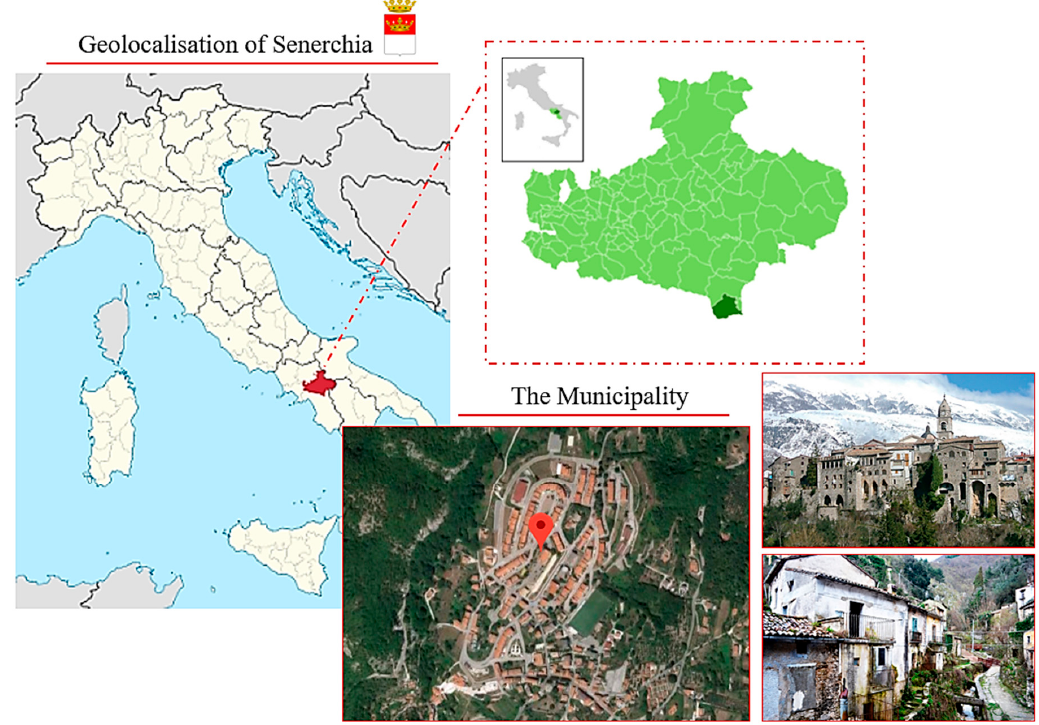
Figure 1. The geographical localisation of the municipality of Senerchia.